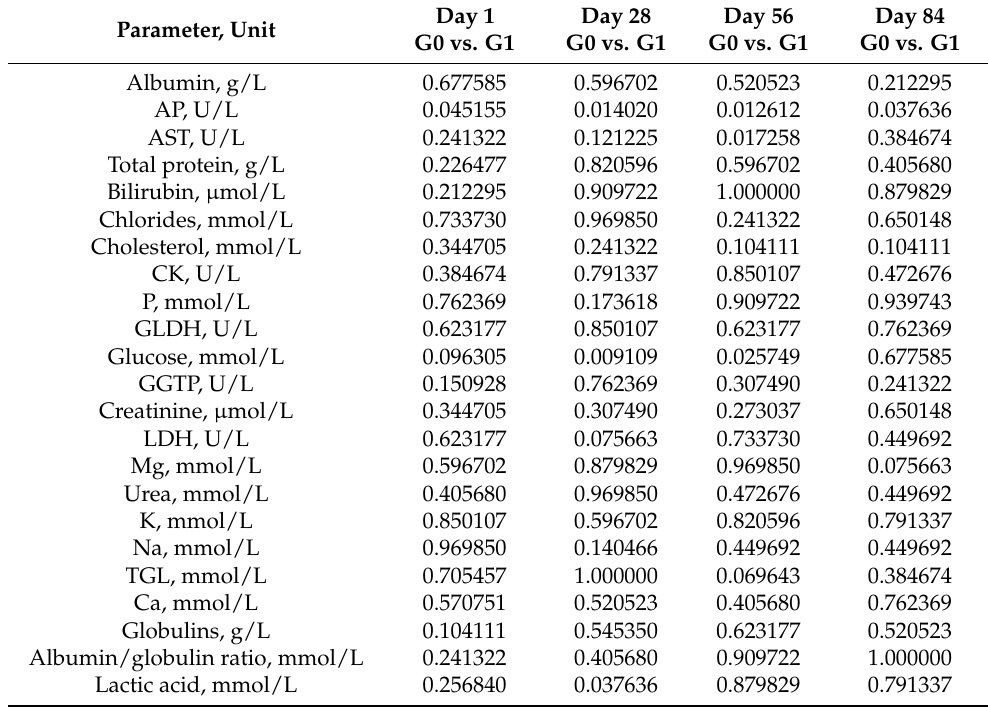
Table 3. p -values representing differences between supplemented (G0) and control groups (G1) in a biochemical analysis.